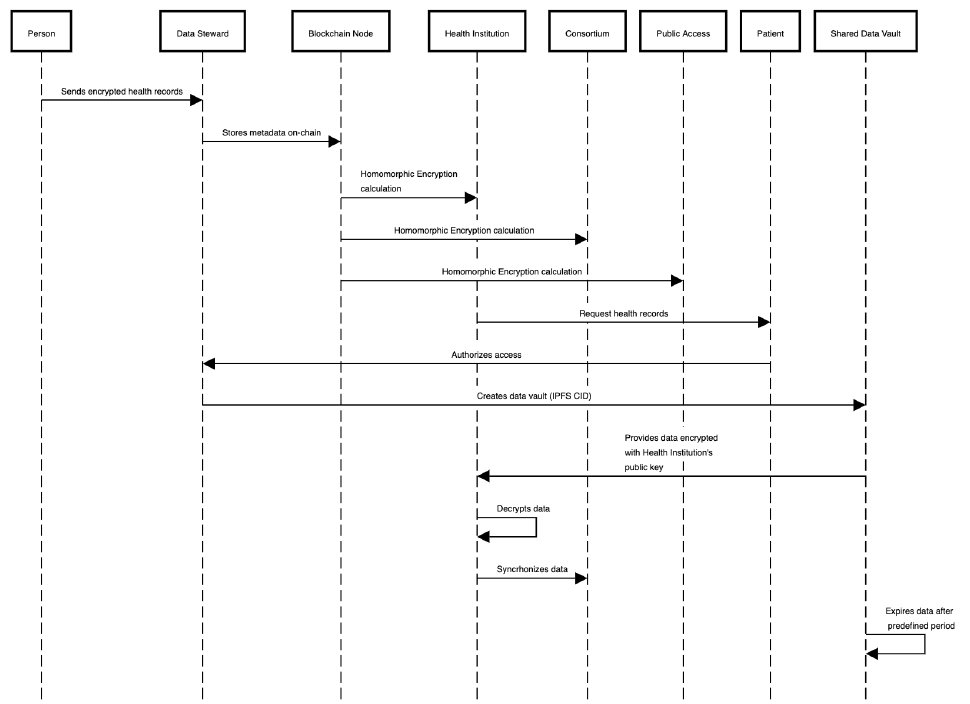
Figure 4. Solution sequence diagram with the main causes of use: (1) Individual shares data with the IPFS network and metadata with the blockchain nodes; (2) Individual authorizes the health institution and consortium to access a portion of data in an SDV for a predefined